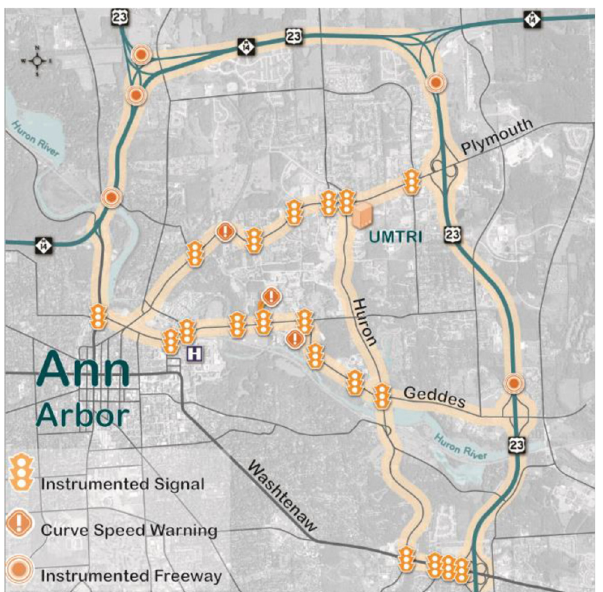
Figure 3 On-road test area of SPMD (Bezzina and Sayer,